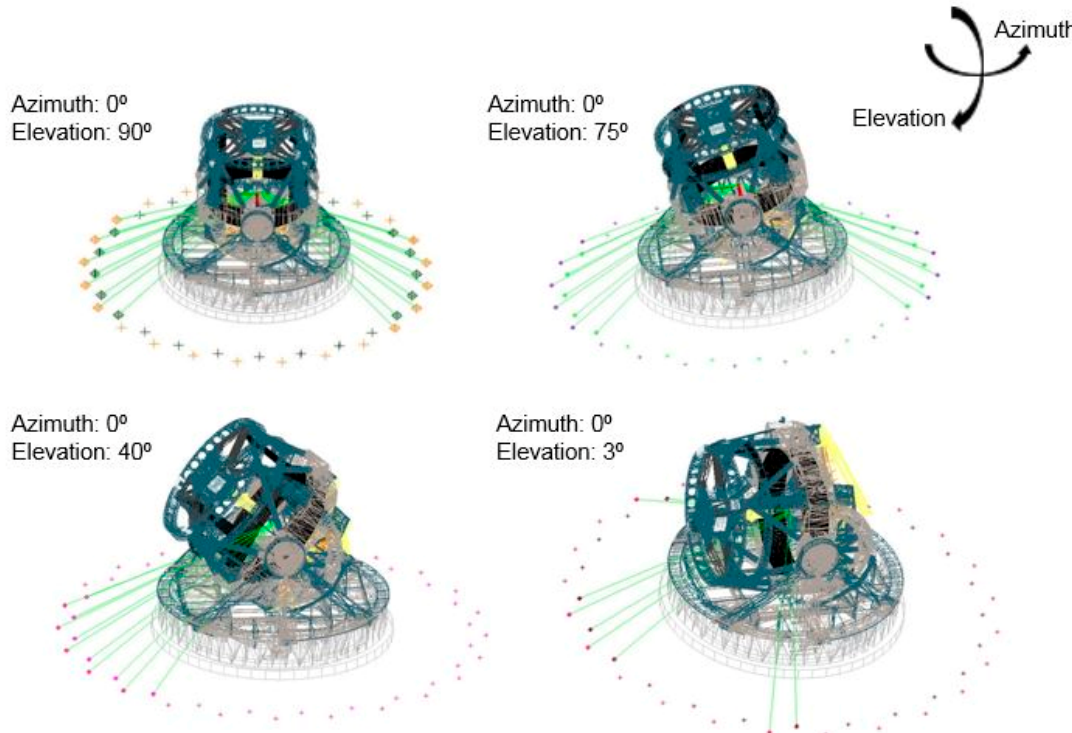
Figure 3. Visibility study overview from inside placed laser tracker, from the zenith to the horizon pointing direction.